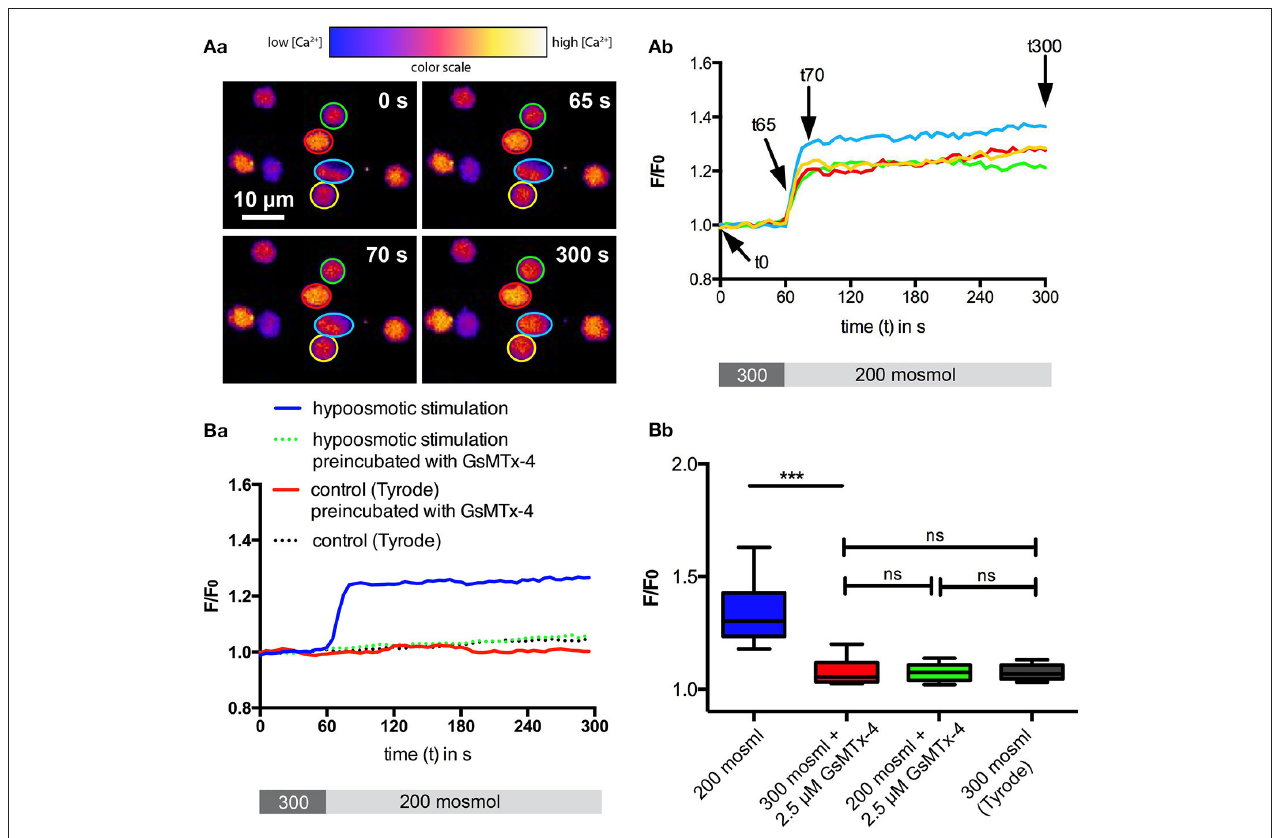
FIGURE 1 | Ca 2 + -signaling of RBCs after hypoosmotic treatment. RBCs in Tyrode solution were exposed to 200 mosmol solution. (A) depicts confocal example images at four time points (Aa) and example traces (Ab) indicating the time points displayed in (Aa) with arrows. The cellular Ca 2 + -response as fluorescence intensity (F/F 0 ) of the Ca 2 + -fluorophor Fluo-4 is plotted over time. The color-coded regions of interest in (Aa) correspond to the colors of the traces in (Ab) . Below the graph in (Ab) the protocol of the solution application (60s, 300 mosmol followed by 240s 200 mosml) is provided. (B) shows the statistical analysis. For each condition between 160 and 210 cells from three different donors were analyzed. The median fluorescence trace (F/F 0 ) over time of all cells is depicted in (Ba) . Below the graph the protocol of the solution application (60s, 300 mosmol followed by 240s 200 mosml) is provided. The analysis of the cellular maximal response (F/F 0 ) is depicted in (Bb) . The response under hypoosmotic conditions in the absence of GsMTx-4 is significantly different relative to all other conditions measured ( p < 0.001; ***).